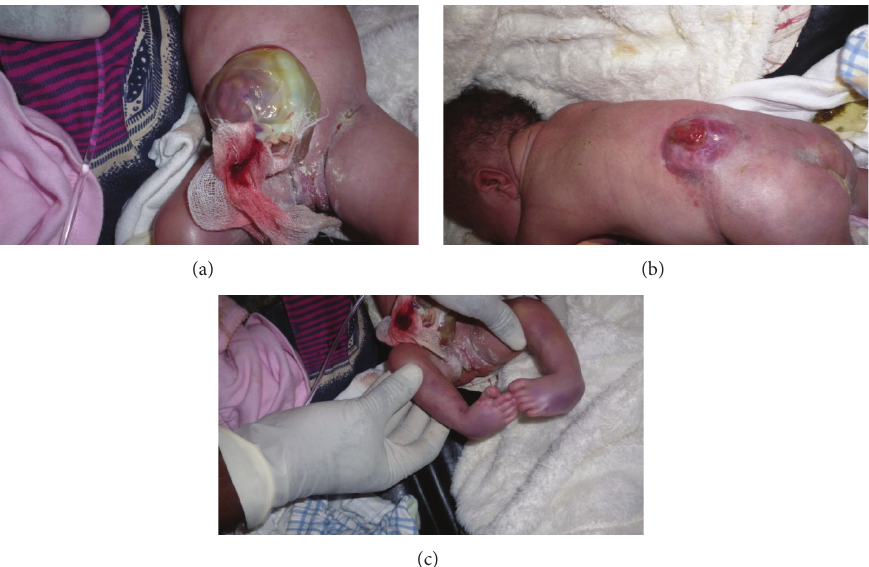
Figure 2: Other features: note (a) exomphalos, (b) meningocele, and (c) bilateral club